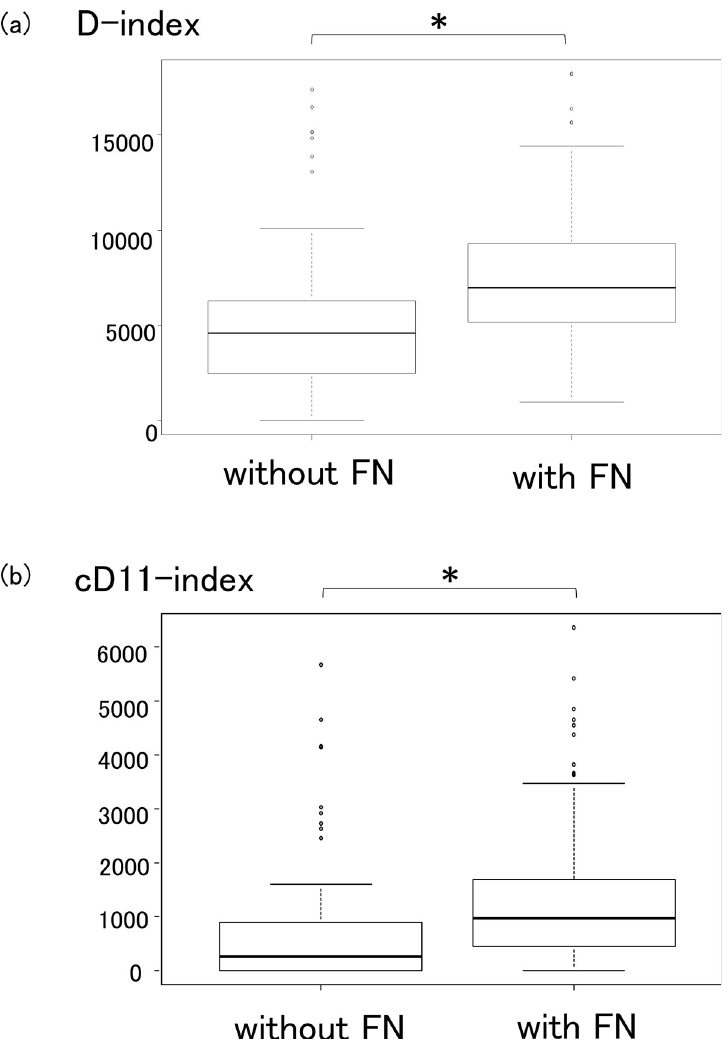
Fig 3. Comparison of the D-index and the c-D-index in patients with and without febrile neutropenia (FN). (a) The D-index was significantly higher in patients with FN (P < 0.001). (b) The c-D-index on day 11 (c-D11-index) was significantly lower in patients with FN (P < 0.001). � Statistically significant (P <